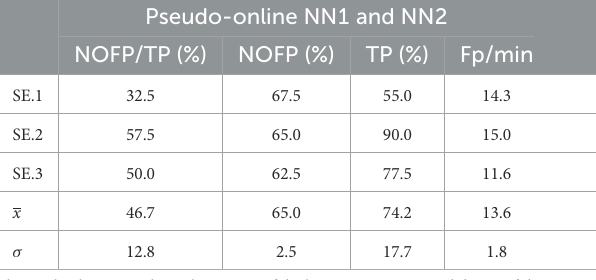
TABLE 6 Performance of the BMI for exoskeleton experiments using NN1+NN2 model. Pseudo-online NN1 and NN2